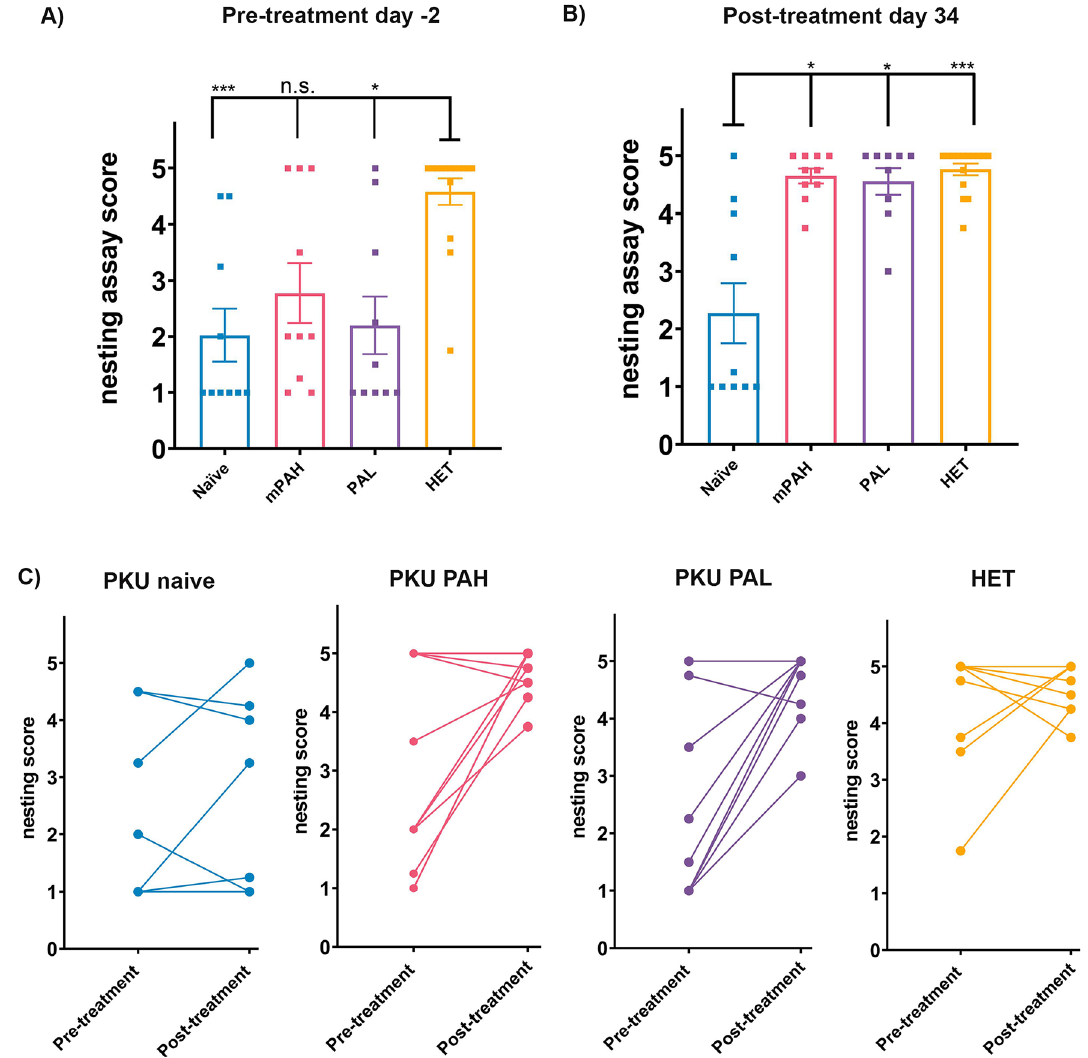
Figure 4. Improvement in nesting behavior in PAH and PAL PAH enu2 mice. (A) Baseline behavior measured 2 days prior to treatment and (B) improved at day 34 post PAH and PAL treatment. (C) Tracking the nesting score of individual mice shows that most PAH and PAL treated mice perform better and receive a higher